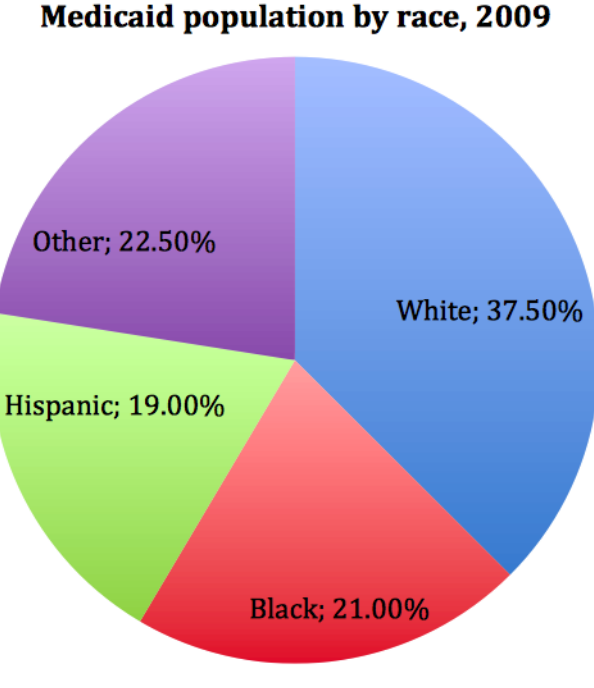
Figure 1: Medicaid Populations by Race,